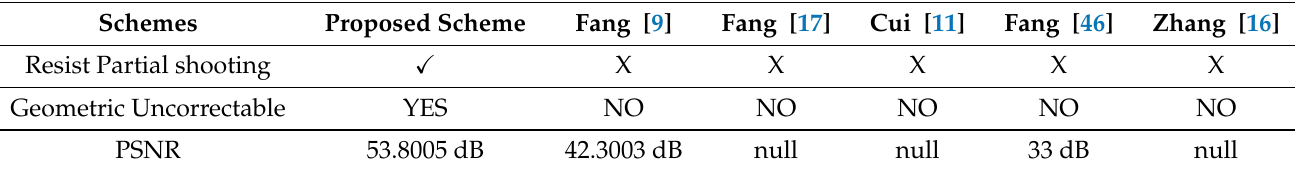
Table 2. Performance pomparison with other